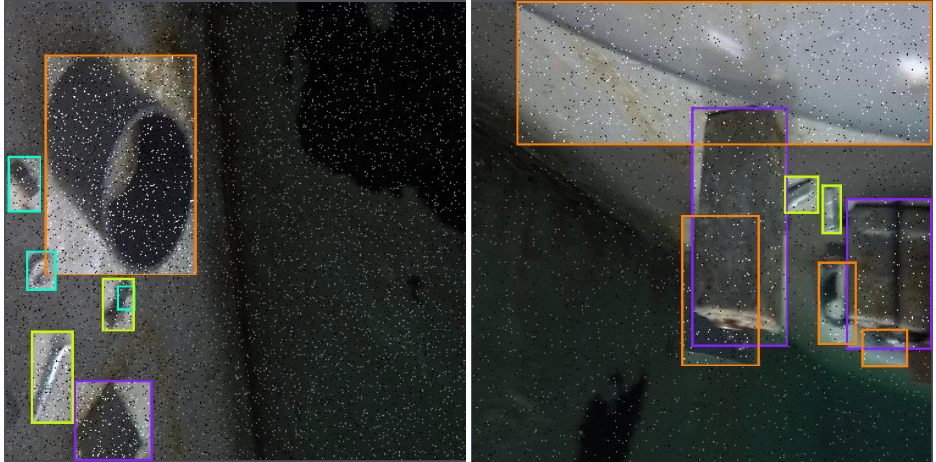
Figure 8. YOLO v4 Dataset preprocessing.